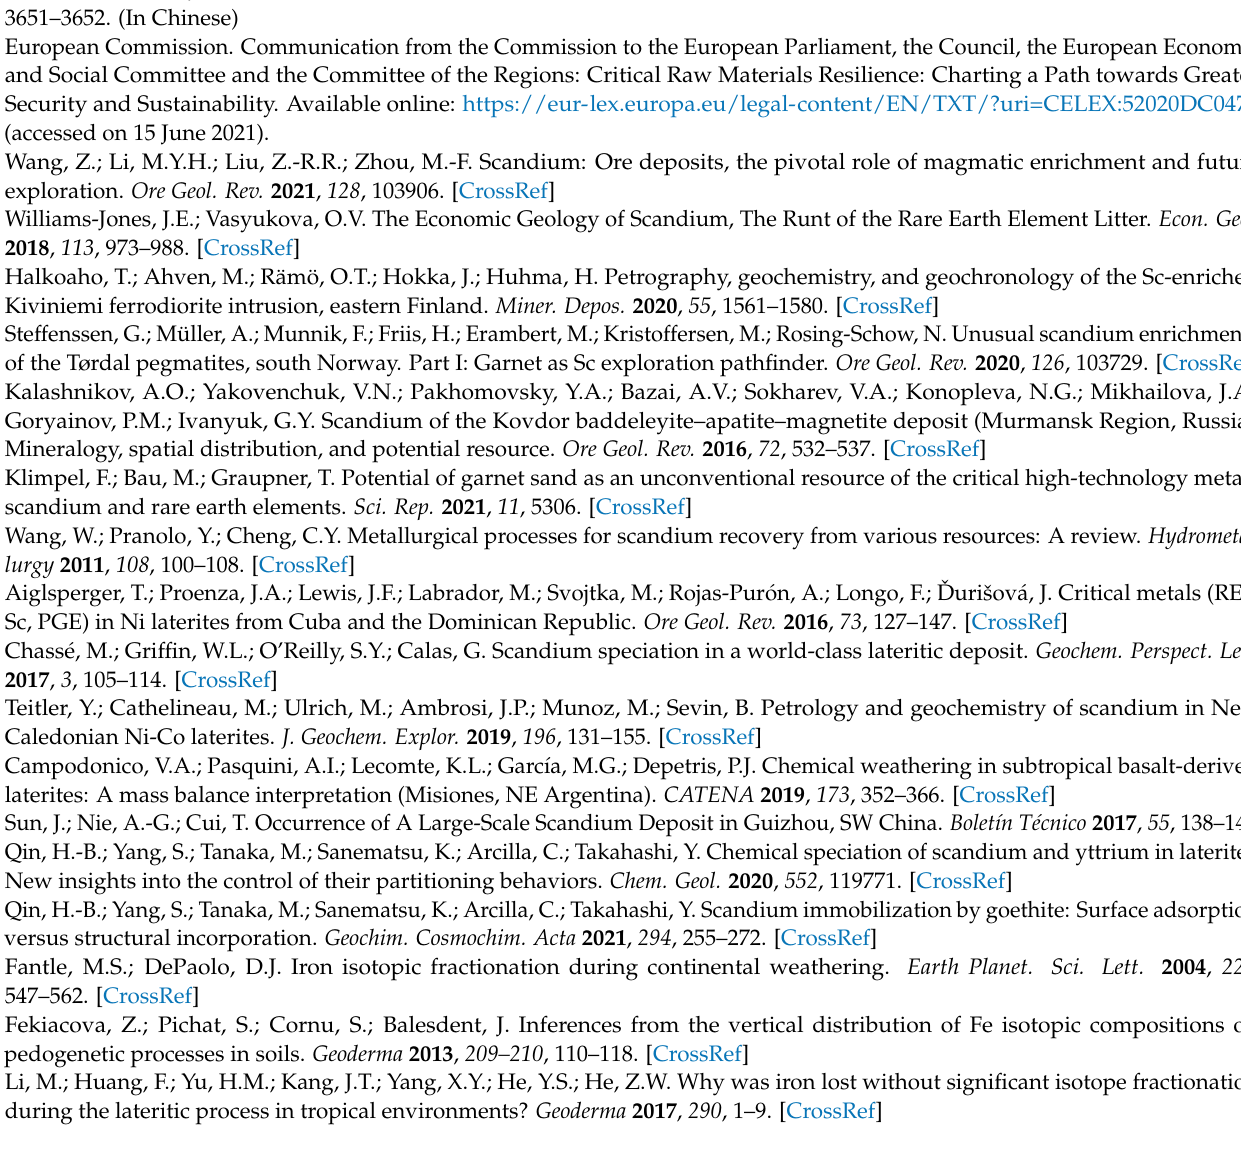
Figure S2. Typical XRD pattern of the weathered basalt in Shazi Sc deposit. Figure S3. Typical XRD pattern of the laterite in Shazi Sc deposit. Figure S4. Geochemical evolution of a typical Sc-rich lateritic profile from Shazi deposit. Table S1. the compositions of different sections of the laterite profile in the shazi